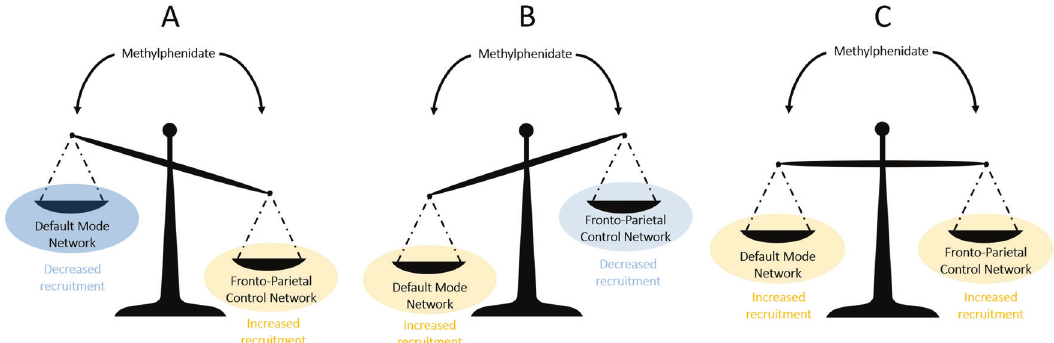
Fig. 1 Schematics of the three predictions underpinning MPH-mediated cognitive enhancement. A MPH-driven increase in the dissociation between the engagement of the FPCN and DMN as re fl ected by (i) stronger activation of fronto-parietal control network (FPCN) regions (task-positive network), which favors cognitive performance and (ii) steeper deactivation of default mode network (DMN) regions (task-negative network), which prevents interference from irrelevant stimuli such as anxiety-related signals. B MPH-driven redistribution of cognitive resources as indicated by lower resource allocation to the FPCN regions (weaker activation), which evidences greater ef fi ciency of the executive control system. Consequently, more resources are available to process and inhibit anxiety, which might be further re fl ected by increased activation of the DMN regions. C MPH-driven expansion of overall resources as re fl ected by stronger activation of both the FPCN regions (i.e., better cognitive performance and inhibition of interference from non-relevant stimuli) and the DMN regions (i.e., processing of anxiety without interfering with cognitive